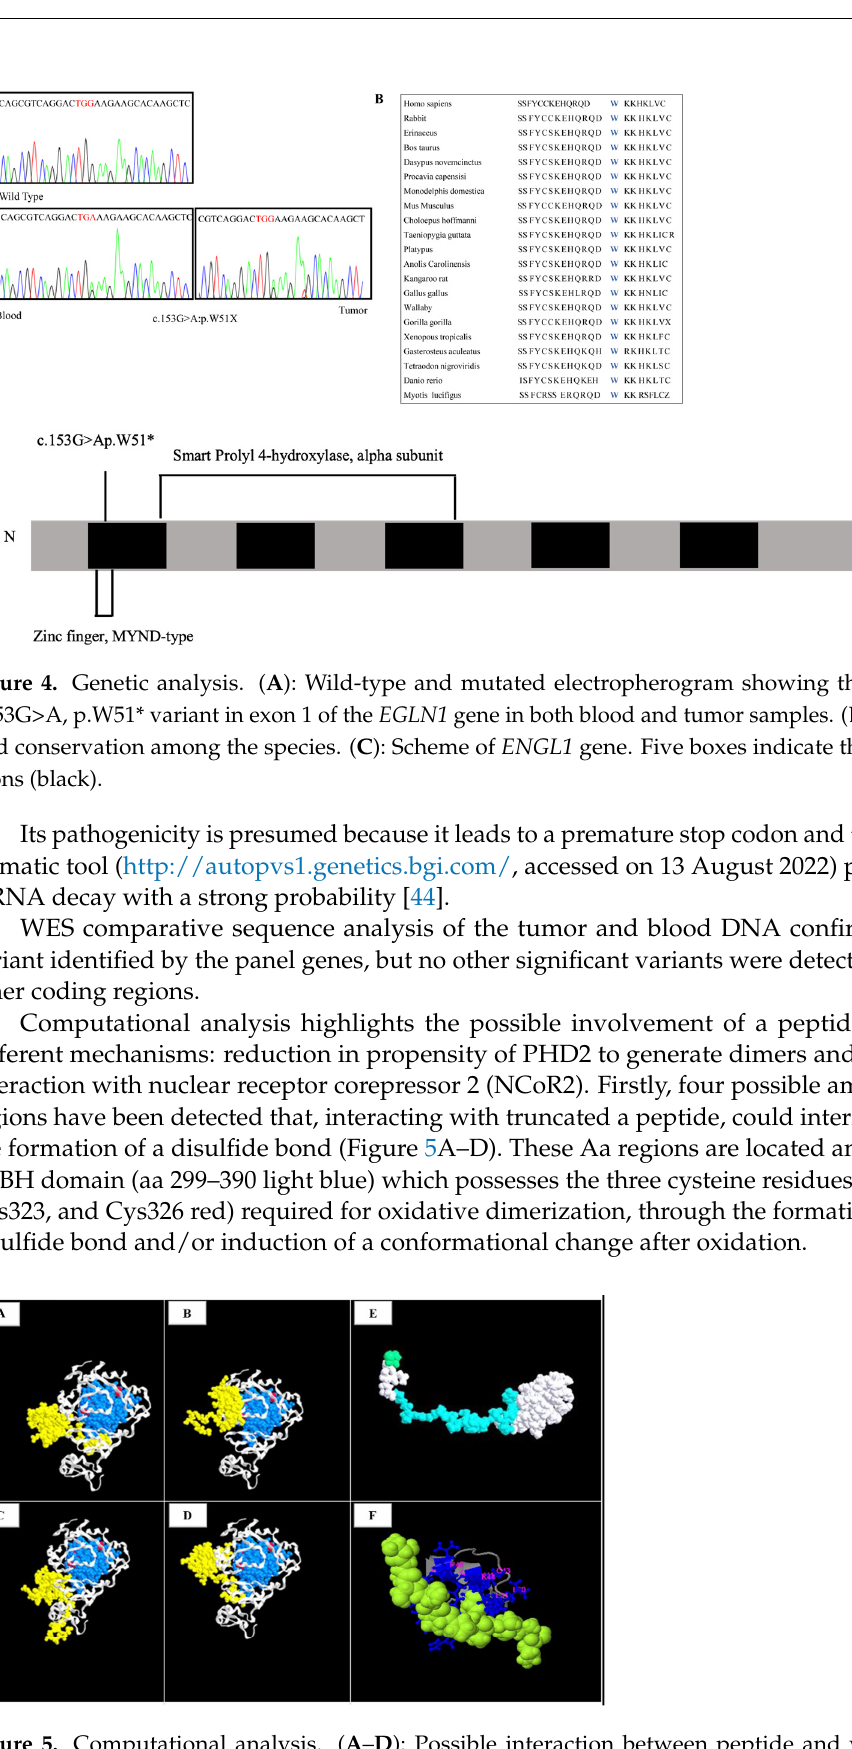
Figure 5. Computational analysis. ( A – D ): Possible interaction between peptide and wt PHD2; ( E ): Three-dimensional model of truncated PHD2 protein; ( F ): NCOR2-truncated PHD2 interaction.